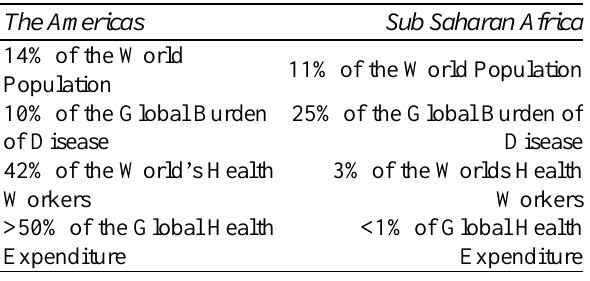
Table 2: The summary of some differences between the Americas and sub-Saharan Africa